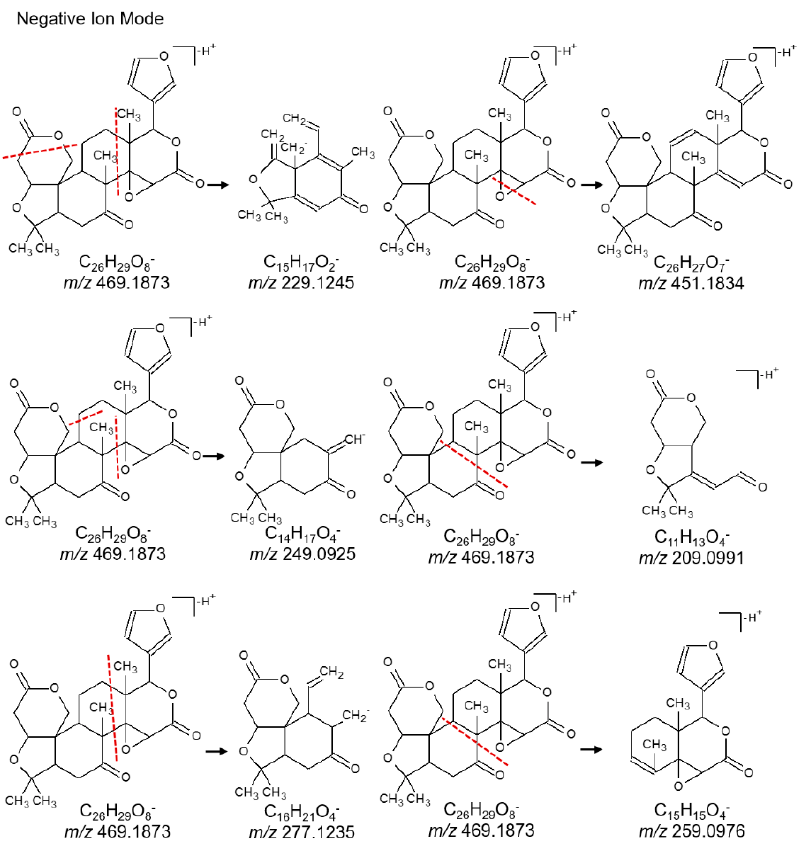
Figure 3. Product ion MS/MS spectrums of limonin in ( A ) positive and ( B ) negative ion modes, and ( C ) fragmentation pathways of limonin.